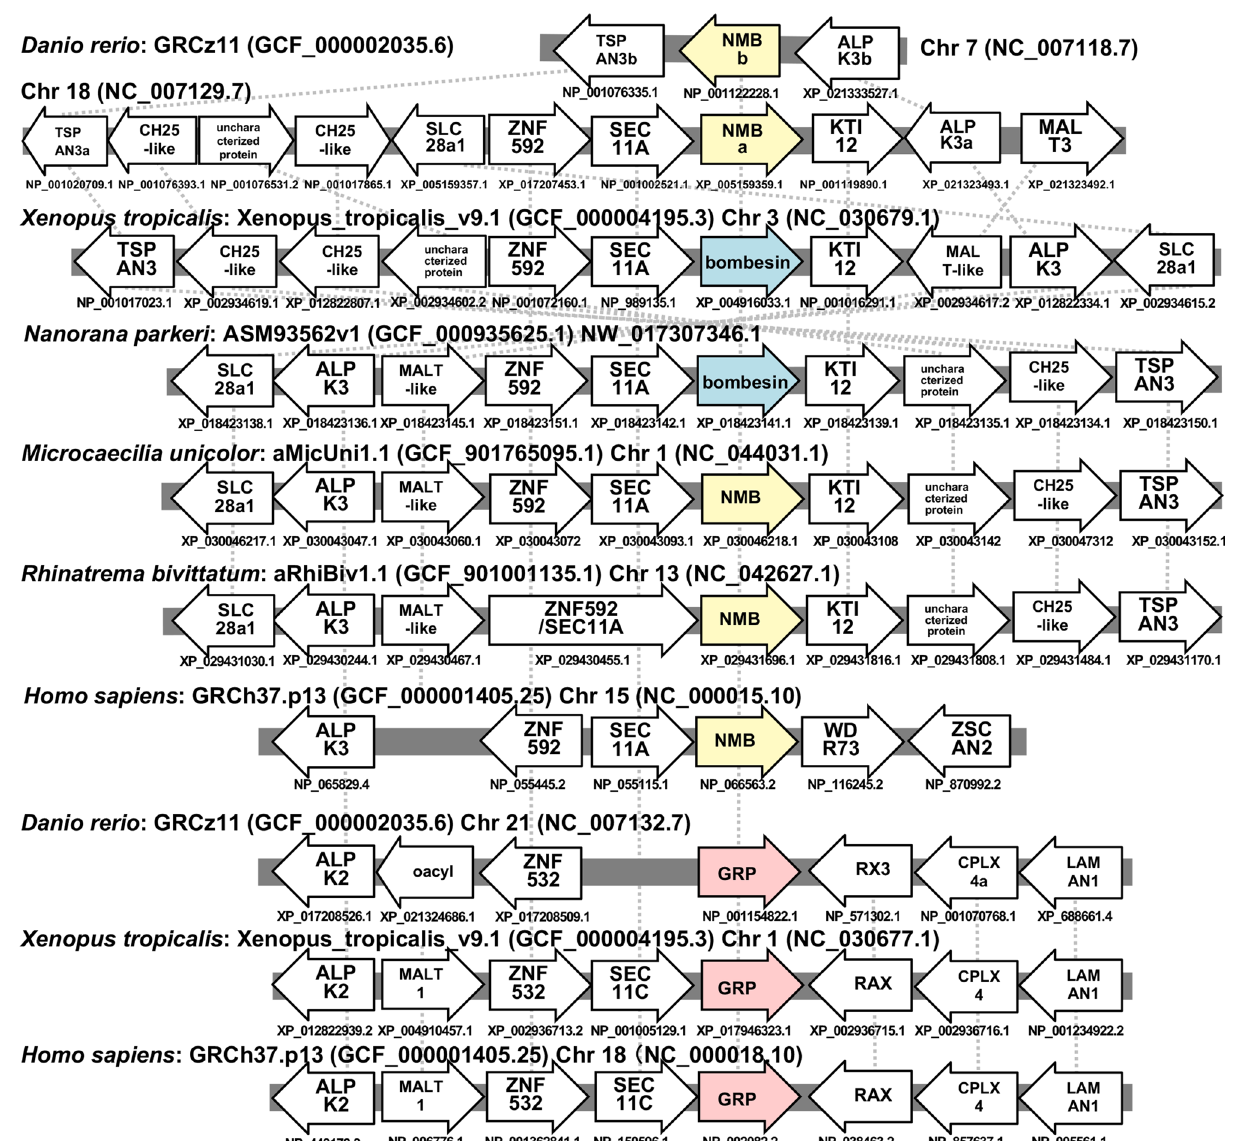
Figure 2. Schematic representation of gene synteny around the neuromedin B (NMB)/bombesin gene and gastrin-releasing peptide (GRP) genes in vertebrates. Horizontal lines (gray) indicate chromosome fragments. Genes are represented as arrows (yellow: NMB gene, blue: bombesin genes, pink: GRP genes, white: other genes) according to their transcriptional orientation. Protein IDs are shown below the genes. Broken lines indicate correspondences of orthologous genes. Gene synteny around the NMB/bombesin gene in vertebrates is highly conserved, suggesting an orthologous relationship between bombesin in frogs and NMB in other